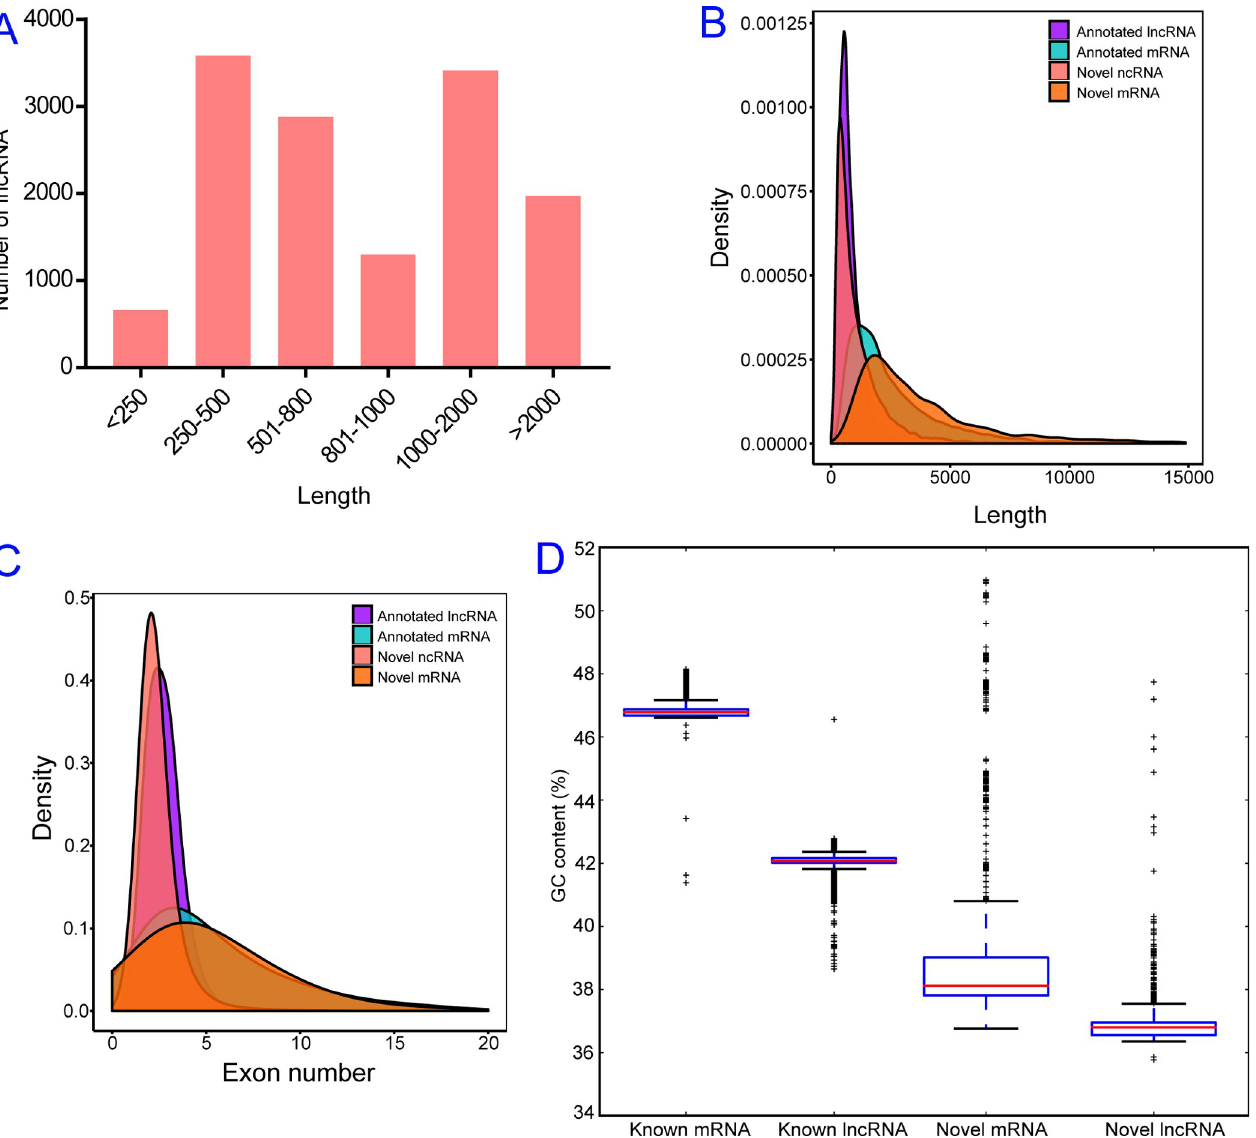
Fig 1. Features of Aedes albopictus lncRNAs. (A) Transcript length distribution of putative lncRNAs; (B) Distribution of transcript length of lncRNAs and mRNAs to verify the length of novel lncRNAs and mRNAs are confirmed with that annotated; (C) Density plot of exons distribution of lncRNAs and mRNAs to verify the length of novel lncRNAs and mRNAs are confirmed with that annotated; (D) Mean GC contents of putative lncRNAs and mRNAs. Error bars represent 95% confidence intervals.